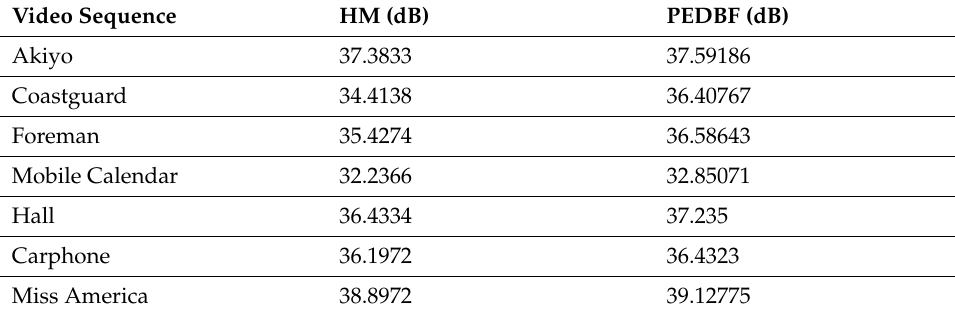
Table 1. PSNR of QCIF video sequences with QP = 32.